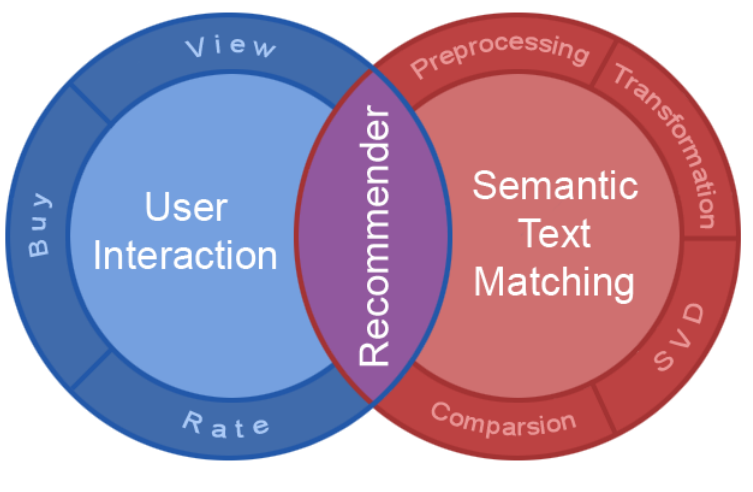
Figure 4. The two interacting components to provide